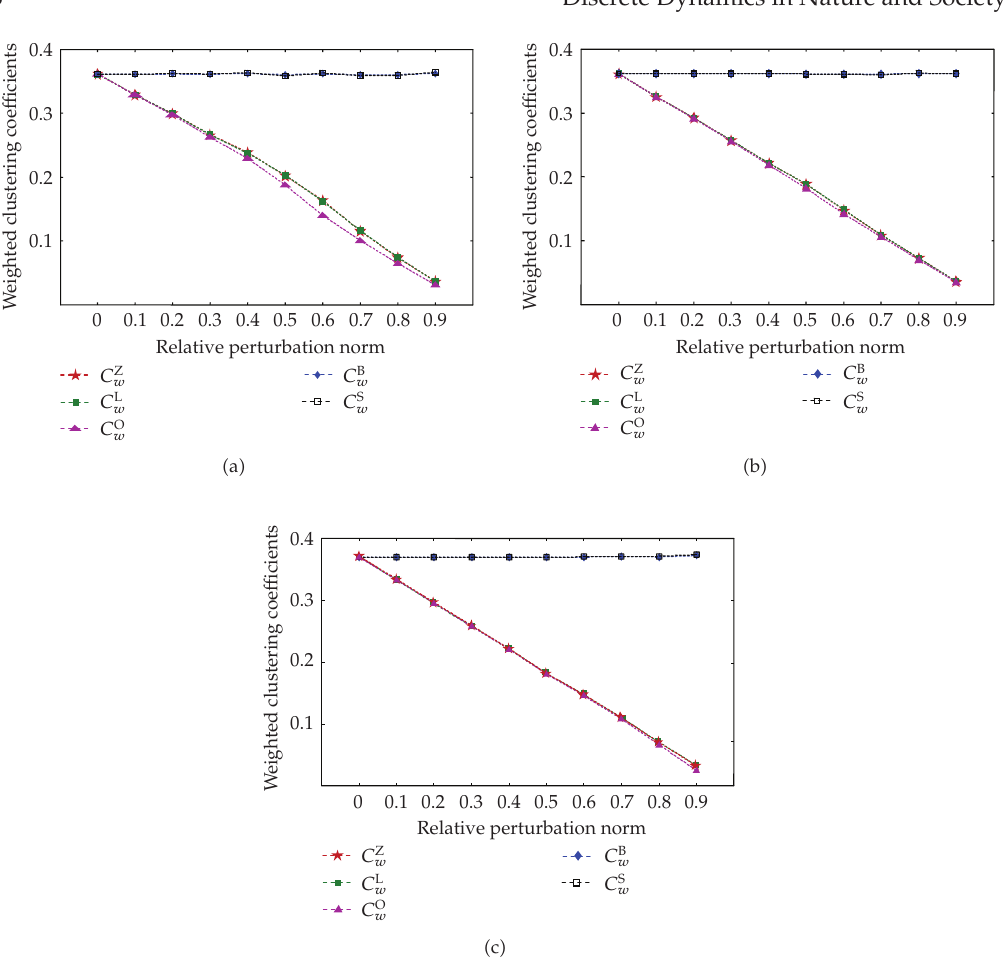
(cid:7) (cid:2) (cid:8) , Lopez- Figure 3: The values of all five weighted clustering coe ffi cients Zhang and Horvath C Z w,i (cid:7) (cid:3) (cid:8) , Onnela et al. C O (cid:7) (cid:4) (cid:8) , Barrat et al. C B (cid:7) (cid:5) (cid:8) , and Serrano et al. C S (cid:7) (cid:6) (cid:8) , in terms Fernandez et al. C L w,i w,i w,i w,i of the relative perturbation norm for the random network (cid:7) Erdos-Renyi model (cid:8) with 100 nodes. (cid:7) a (cid:8) The weights are randomly generated numbers following the uniform distribution; (cid:7) b (cid:8) the weights are randomly generated numbers following the normal distribution; (cid:7) c (cid:8) the weights are randomly generated